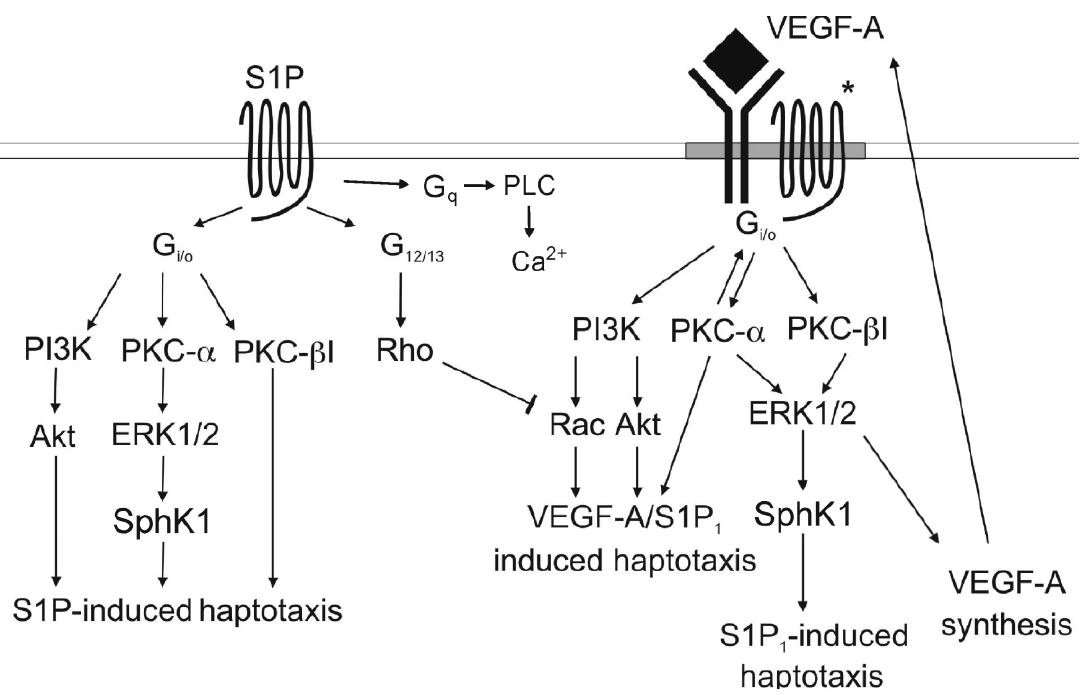
Figure 1. Schematic presentation of the different signaling pathways employed by S1P and VEGF in stimulating migration of follicular ML-1 thyroid cancer cells. The * in the Figure denotes a complex between S1P receptors and VEGF receptor